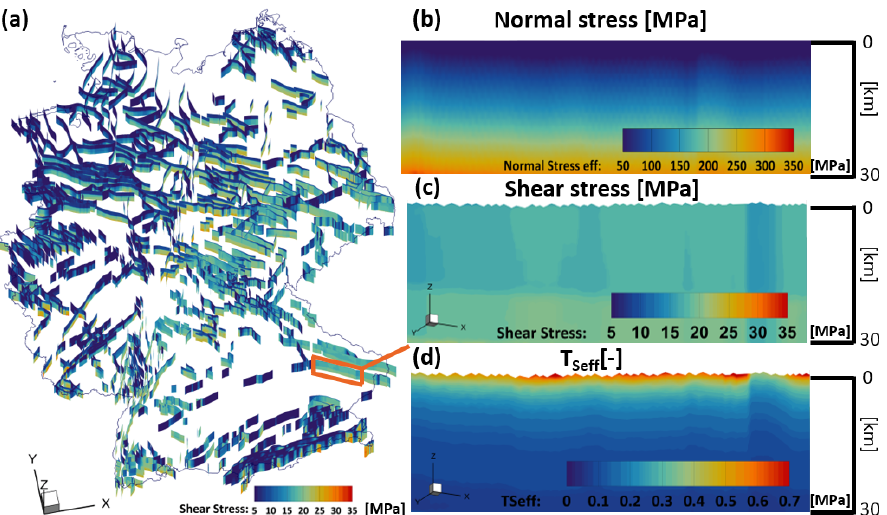
Figure 9. (a) Shear stress τ in MPa of the Vertical fault set with the color map ranging from 5 to 35MPa (oblique view). (b) – (d) Zoomed in view of the Landshut–Neuötting Fault normal to the strike reaching to a depth of around 30km; (b) effective normal stress σ neff with the color map ranging from 50 to 350MPa; (c) shear stress τ with the color map ranging from 5 to 35MPa; (d) T Seff of the Landshut–Neuötting Fault is shown with the color map ranging between 0 and 0.7. ©EuroGeographics for the administrative boundaries.